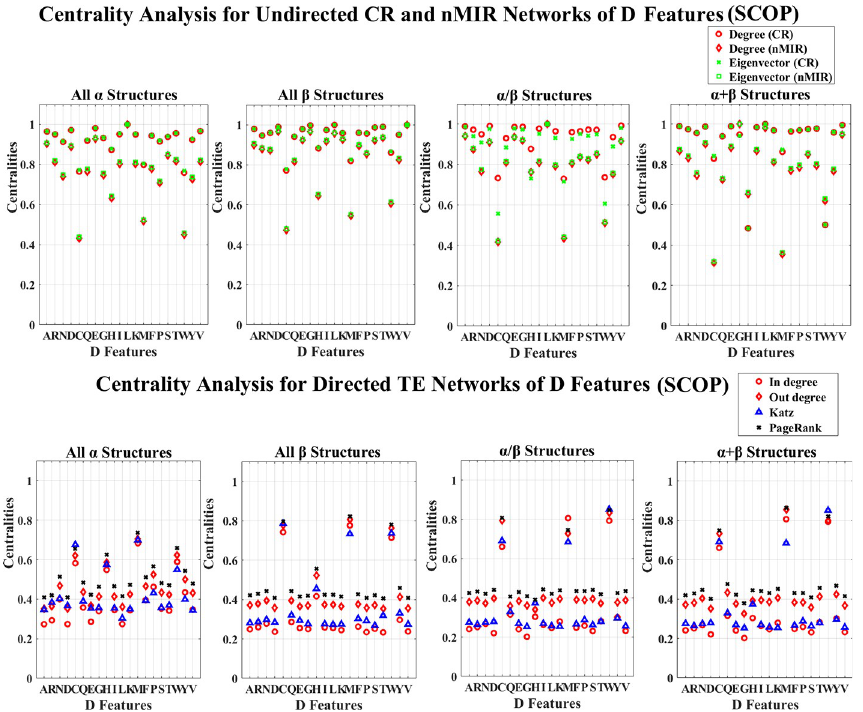
Fig 9. Centrality analysis for the networks of PseAAC features with λ = 0 (CATH). This figure shows the centrality results for the undirected CR and nMIR networks (upper plots) and the directed TE networks (bottom plots) for the PseAAC features with λ = 0 (CATH